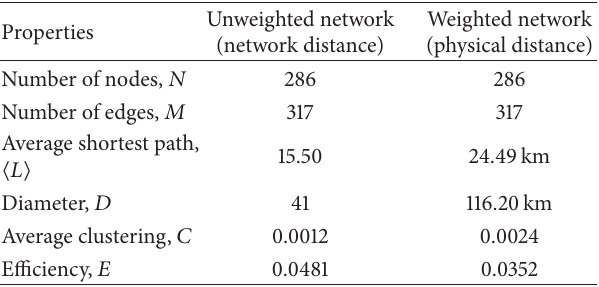
Table 1: Statistical properties of the Shanghai RTS